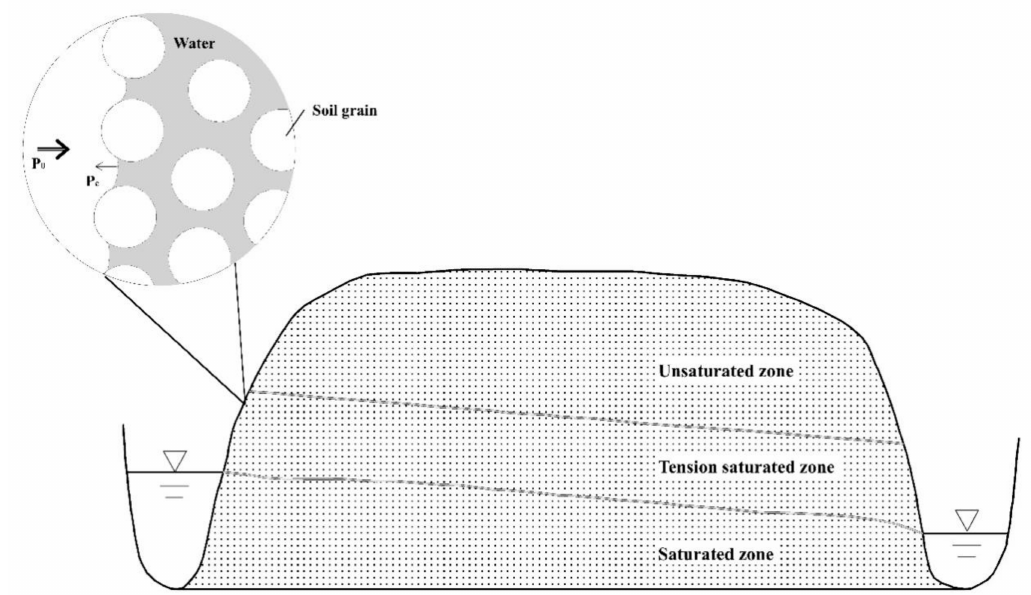
Figure 6. Pore meniscus in the water–vapor interface of the seepage area (modified by